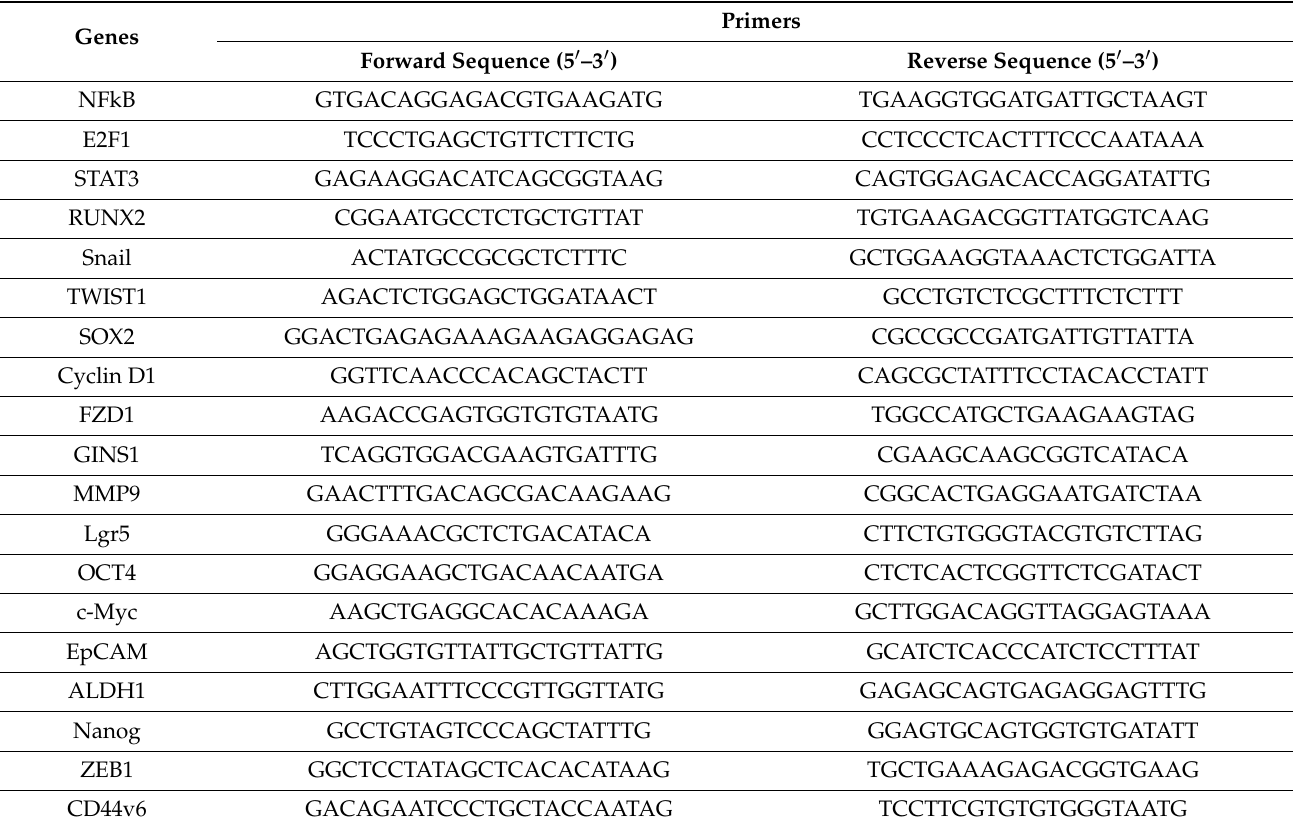
Table 2. Real-time PCR (QPCR) primers for various genes used in this study. Genes